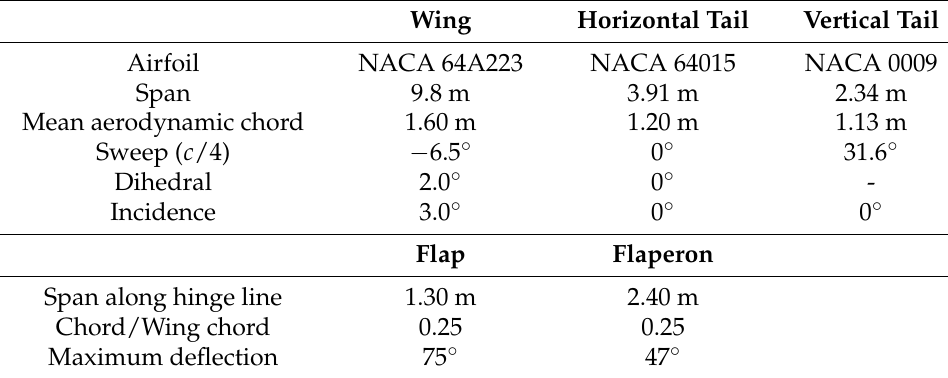
Table 6. Geometric characteristics of the XV-15 [41].